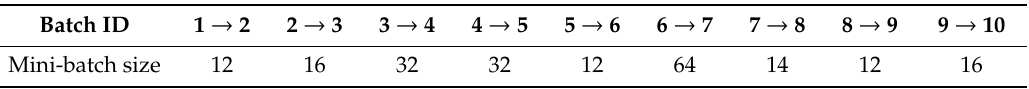
Table 5. Corresponding Parameter Setting (mini-batch size) of the WDLFR under Experimental Setting